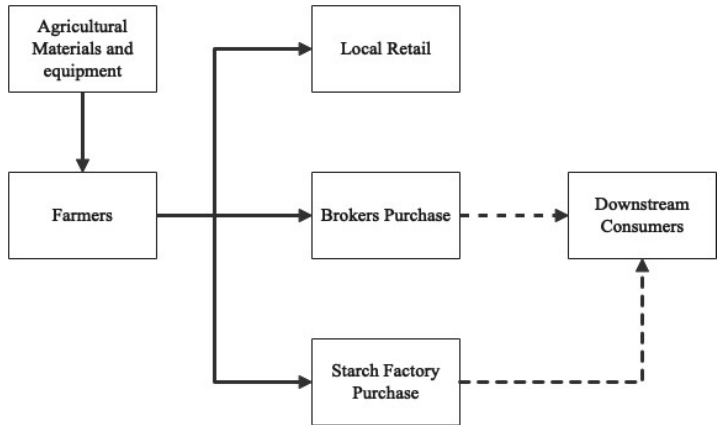
Figure 2. Traditional ASC model.